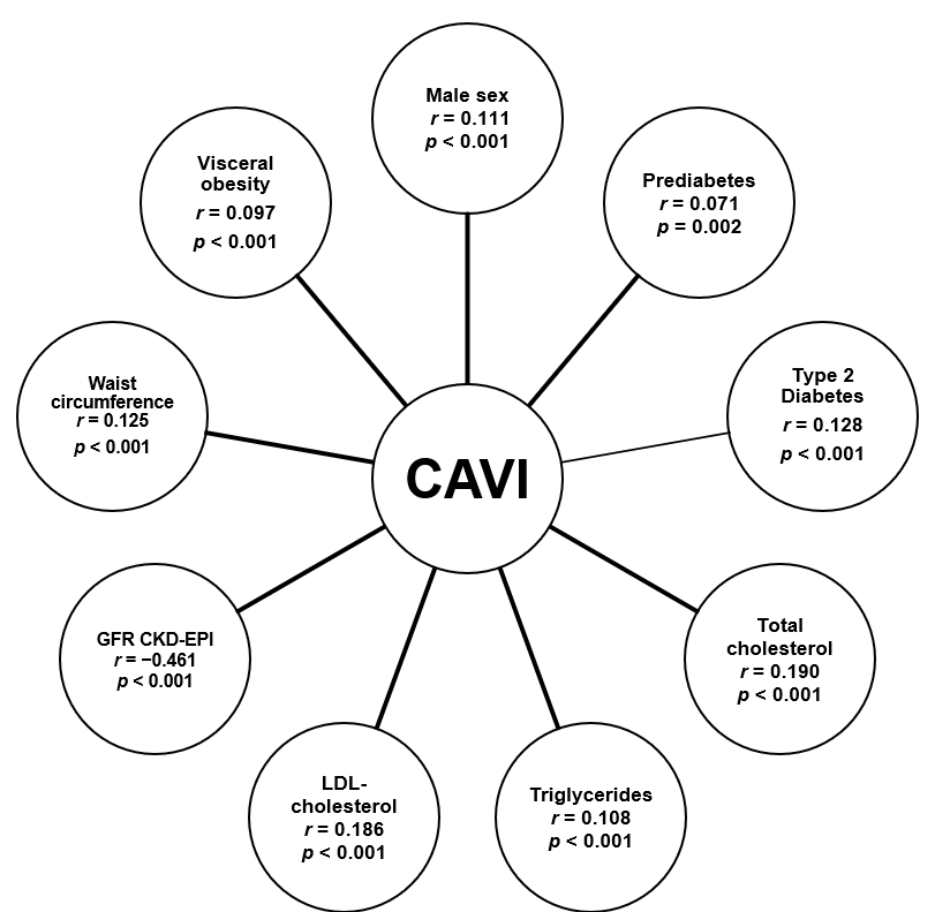
Figure 3. Correlation of CAVI with basic parameters in the total sample CAVI—cardio-ankle vascular index, GFR CKD-EPI— glomerular filtration rate calculated using the CKD- EPI formulа, LDL cholesterol— low density lipoprotein cholesterol.